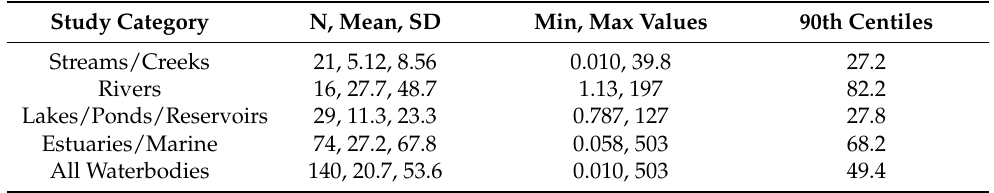
Table 5. Descriptive statistics and centile calculation for five different categories of studies with AVS field data results ( µ mole/g dry